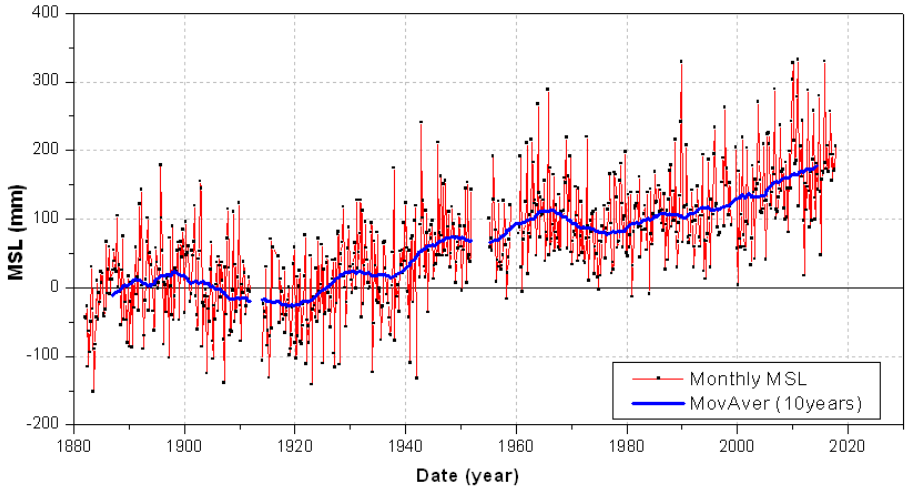
Figure 2. Cascais TG secular series of monthly MSL, from 1882 to 2017, relative to the national vertical datum, and a moving average (MovAver) of the 10-year base period.